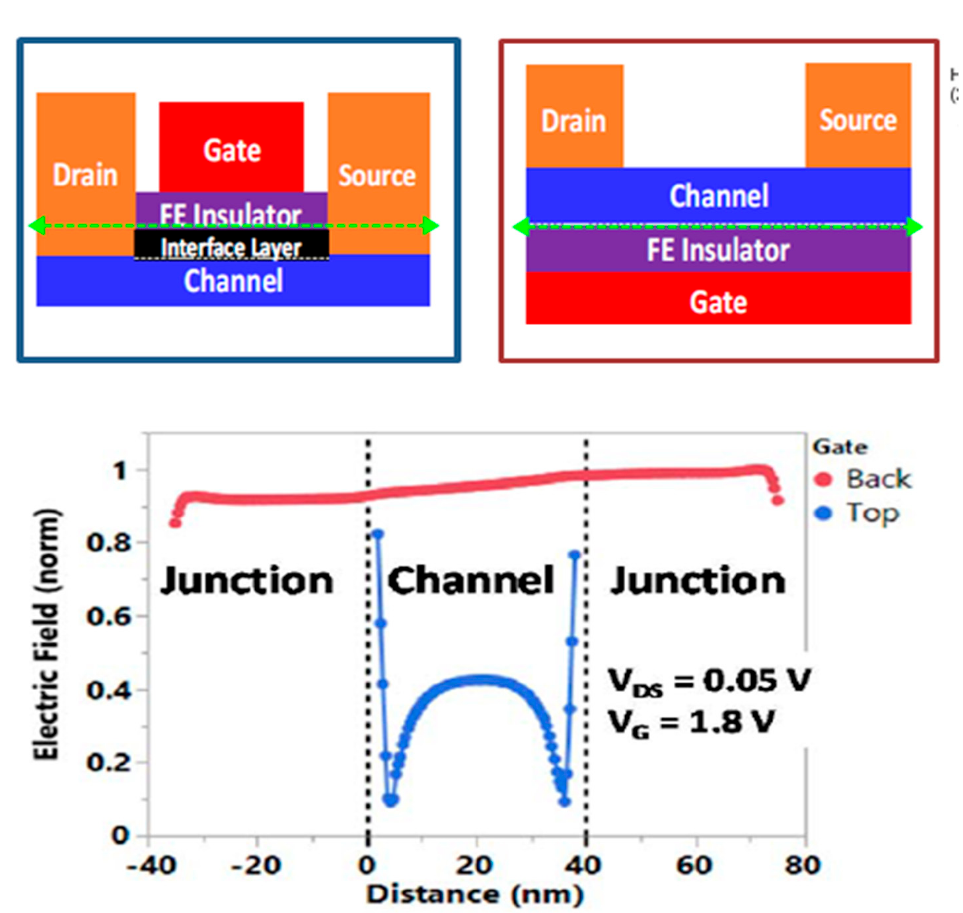
Figure 5. FeFET design change to improve field uniformity in ferroelectric along the channel. Copyright © 2020, IEEE [99].